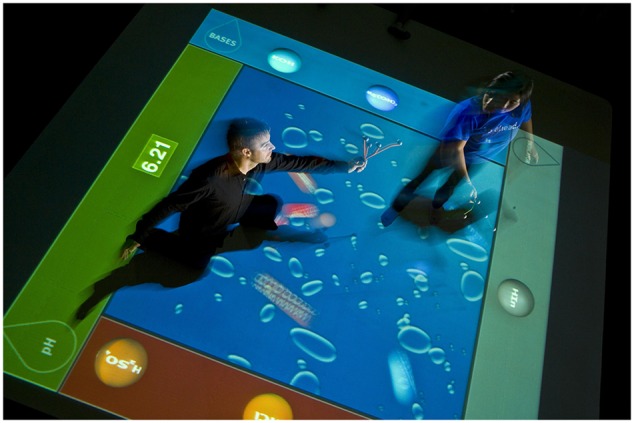
Example of SMALLab floor projection with marker-based motion capture.